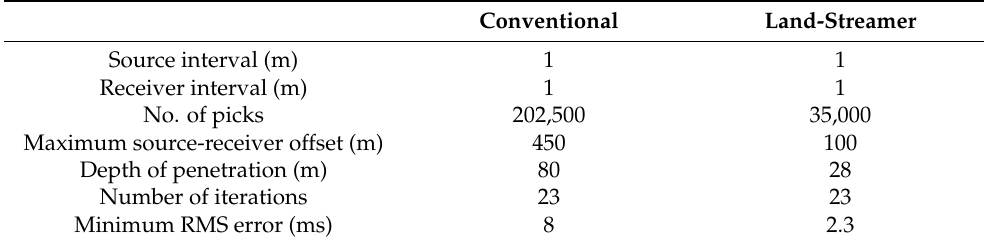
Table 3. Comparison between conventional and land-streamer results. Conventional Land-Streamer Source interval (m) 1 1 Receiver interval (m) 1 1 No. of picks 202,500 35,000 Maximum source-receiver offset (m) 450 100 Depth of penetration (m) 80 28 Number of iterations 23 Minimum RMS error